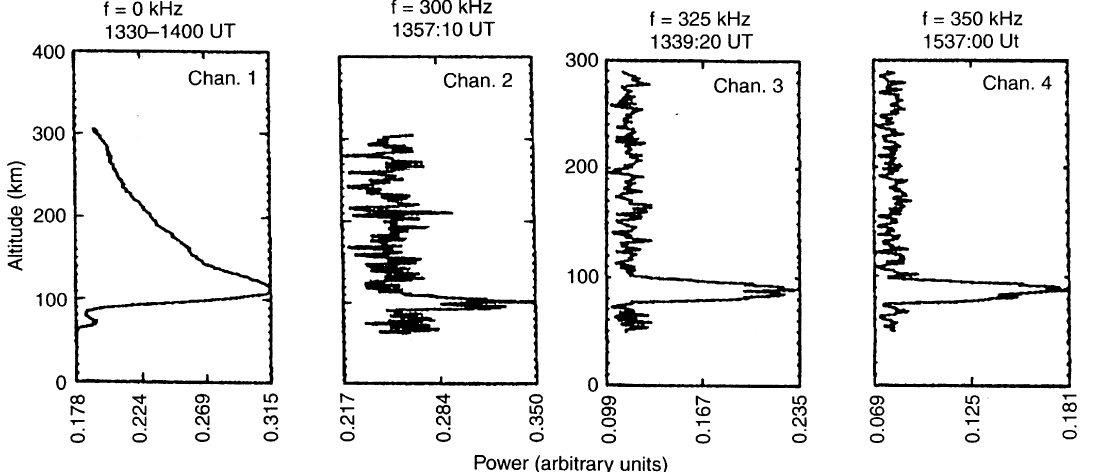
receiver channels centred at f " 300, 325 and 350 kHz relative to the transmitted frequency. The power is in arbitrary units. (cid:97) " 78.6 ° at